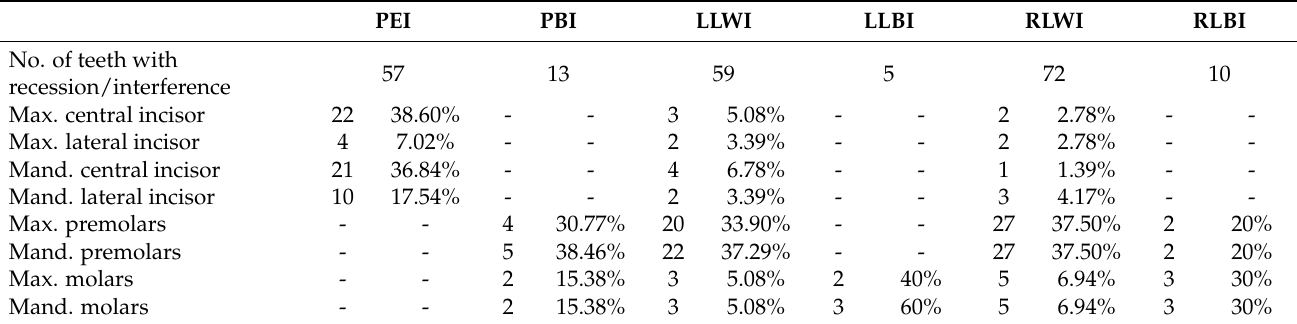
Table 2. Occlusal interferences and gingival recession distribution on teeth